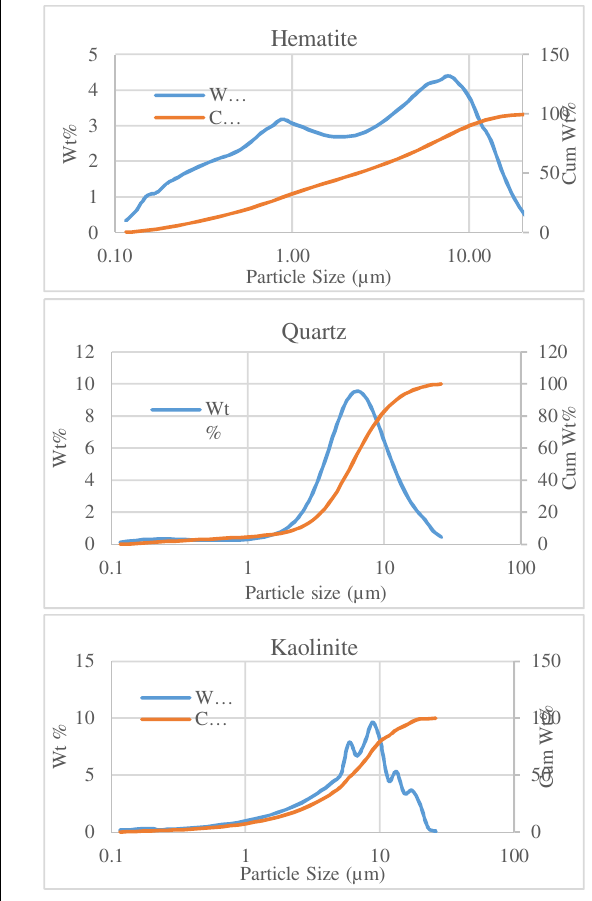
Fig. 1: Particle Size Analysis of Hematite, Quartz and Kaolinite